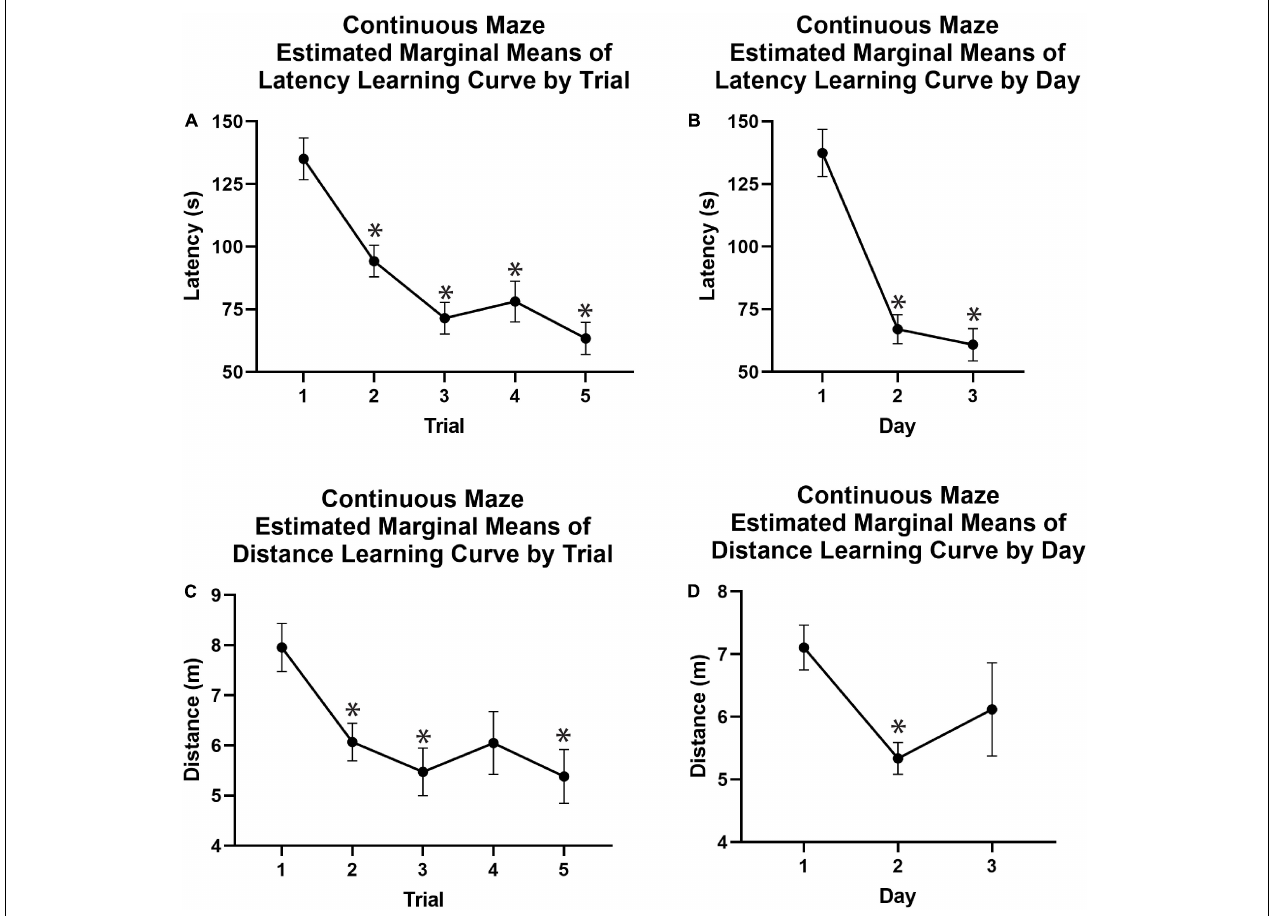
FIGURE 6 | Continuous spatial maze learning curves using estimated marginal means. (A) Latency to the reward chamber was significantly reduced on average in Trials 2, 3, 4, and 5 as compared to Trial 1 across Days 1–3, demonstrating a main effect of trial independent of day for latency. (B) The mean latency for each learning day showed that animals reached the reward chamber in significantly less time on Days 2 and 3 compared to Day 1. (C) Animals exhibited significant learning effects when comparing distance traveled on Trials 2, 3, and 5 to that of Trial 1 across Days 1–3, demonstrating a main effect of Trial independent of Day for distance. (D) Animals traveled significantly less distance on Day 2 compared to Day 1. Covariates appearing in the model were evaluated at the following values: Mass = 54.60, Age = 2.94.* p < 0.05. m, meters; s,